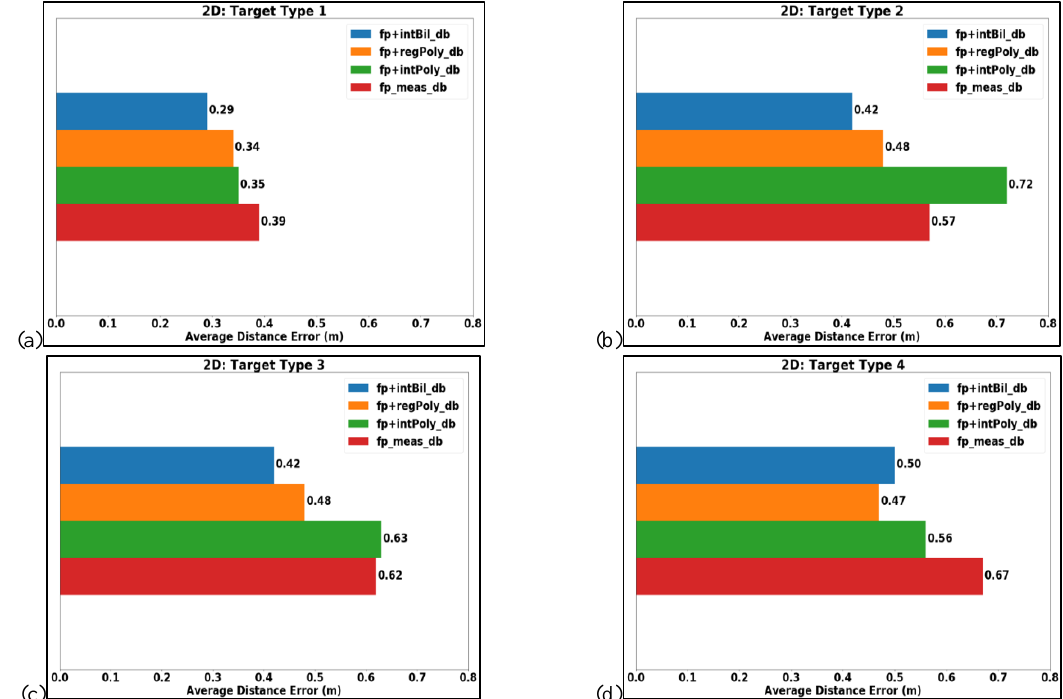
Figure 23. Localization results comparison, a) target type 1, b) target type 2, c) target type 3, and d) target type